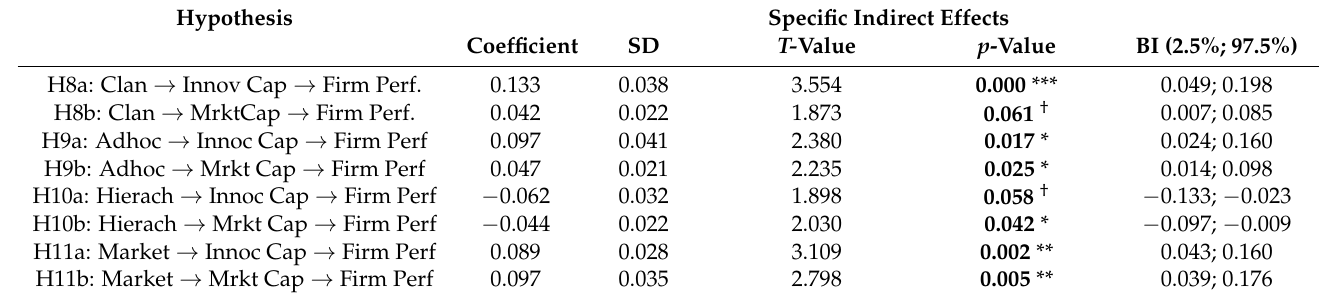
Table 5. Results of indirect effects with bootstrapping (based on Model